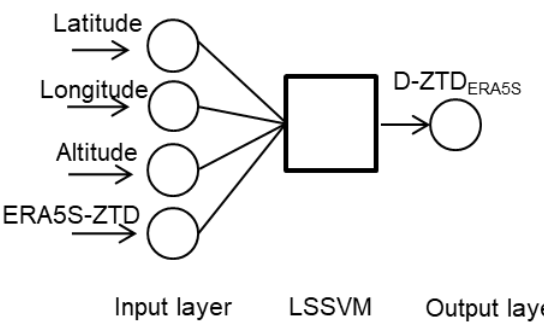
Figure 2. Network structure of Scheme 2.